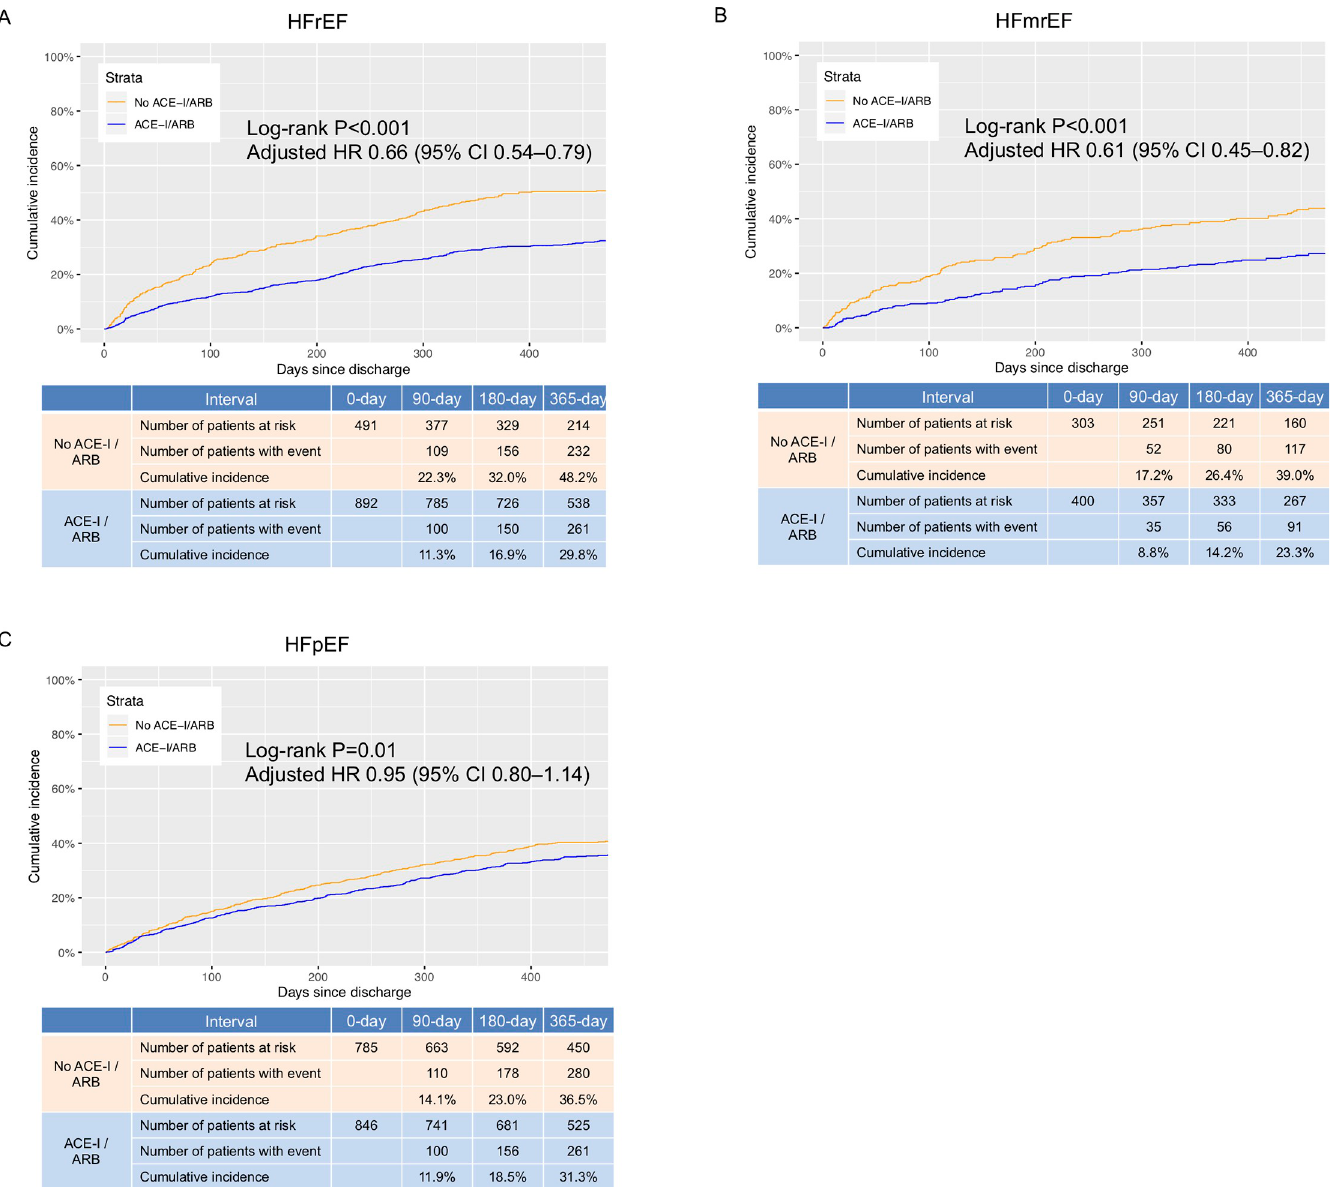
Fig 2. The Kaplan-Meier curves for the primary endpoint stratified by the LVEF category; ACE-I/ARB group versus no ACE-I/ARB group. The Kaplan-Meier curves represent the cumulative incidences of the primary outcome measure (a composite of all-cause death and HF hospitalization). (A) HFrEF, (B) HFmrEF, (C) HFpEF. LVEF, left ventricular ejection fraction; ACE-I, angiotensin-converting enzyme inhibitors; ARB, angiotensin receptor blockers; CI, confidence interval; HFmrEF, heart failure with mid-range ejection fraction; HFpEF, heart failure with preserved ejection fraction; HFrEF, heart failure with reduced ejection fraction; HR, hazard